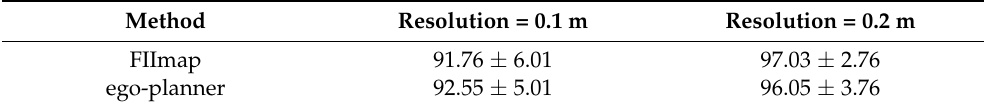
Table 1. Accuracy experiments on the laboratory corridor dataset.